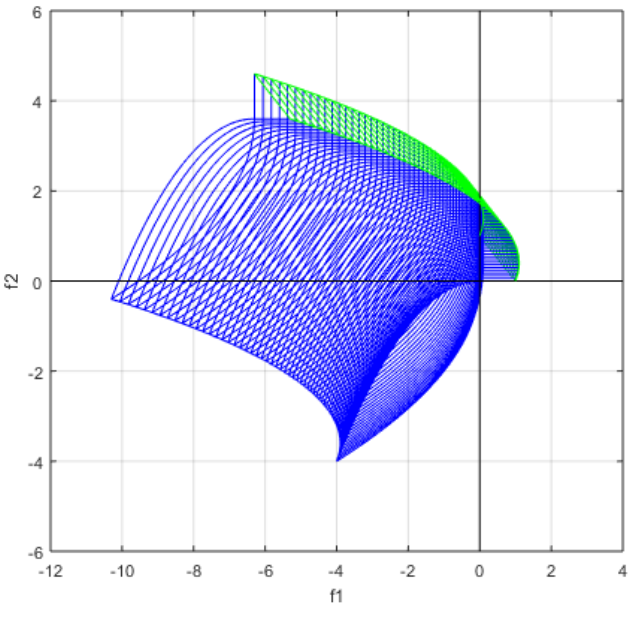
Figure 3. Payoff space of the game G